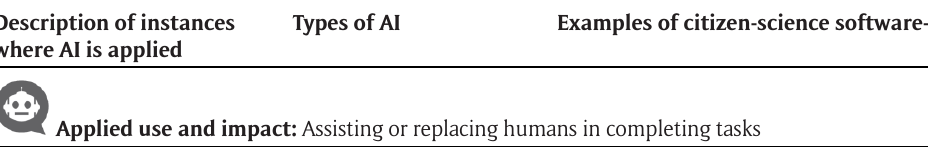
Table 1: Summary of the categories of AI used in citizen science and their applications. (The list of categories is not ranked in terms of